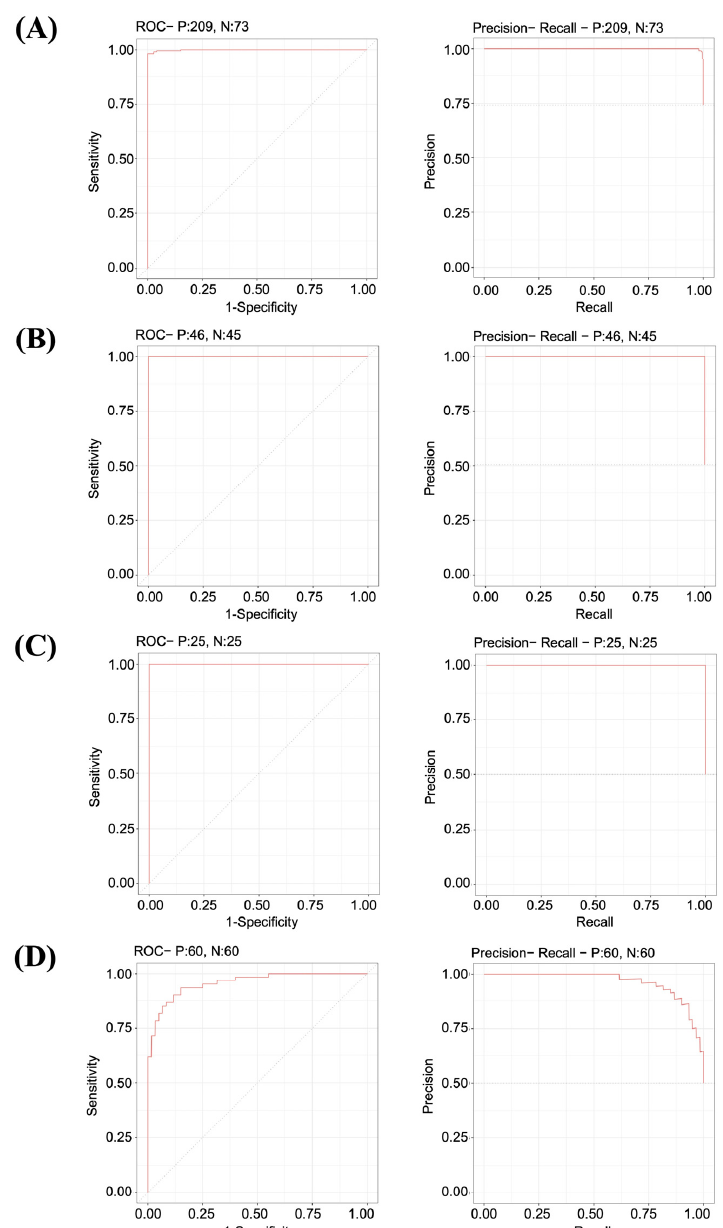
Figure 4. Performance of the LASSO model on the independent test datasets. ( A ) Performance on the TD1 dataset that contained 209 cancer and 73 normal samples, with the ROC curve showing an AUC of 0.9988 and the PRC curve showing an AUC of 0.999. ( B ) Performance on the GSE18842 dataset that contained 46 cancer and 45 normal samples, with the ROC curve showing an AUC of >0.99 and the PRC curve showing an AUC of >0.99. ( C ) Performance on the GSE27262 dataset that contained 25 cancer and 25 normal samples, with the ROC curve showing an AUC of >0.99 and the PRC curve showing an AUC of >0.99. ( D ) Performance on the GSE19804 dataset that contained 60 cancer and 60 normal samples, with the ROC curve showing an AUC of 0.95 and the PRC curve showing an AUC of 0.96. The ROC graphs plot the true positive rate (sensitivity on the y -axis) versus the false positive rate (1-specificity on the x -axis) for all possible thresholds. The value of the AUC varies from 0 to 1. The larger the value of the AUC, the better the model can differentiate between lung cancer and normal samples. The diagonal dashed line represents an AUC of 0.5, which indicates random prediction by the model. The PRC plots the precision (positive predictive value on the y -axis) versus the recall (sensitivity or true positive rate on the x -axis) for all possible thresholds. The larger the AUC, the better the model’s performance. The ROC and PRC curves were built with the R package precrec